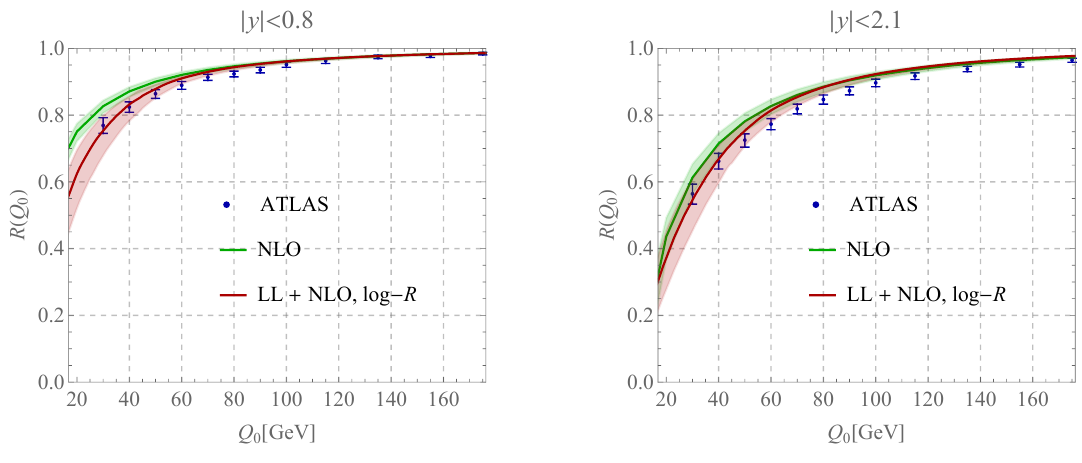
Figure 9 . Same as (cid:12)gure 8, except that the log- R matching scheme was